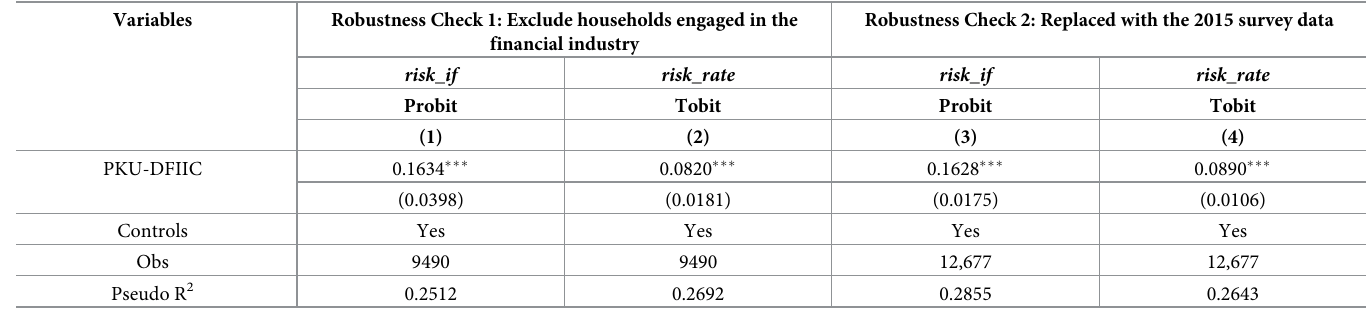
Table 8. Robustness